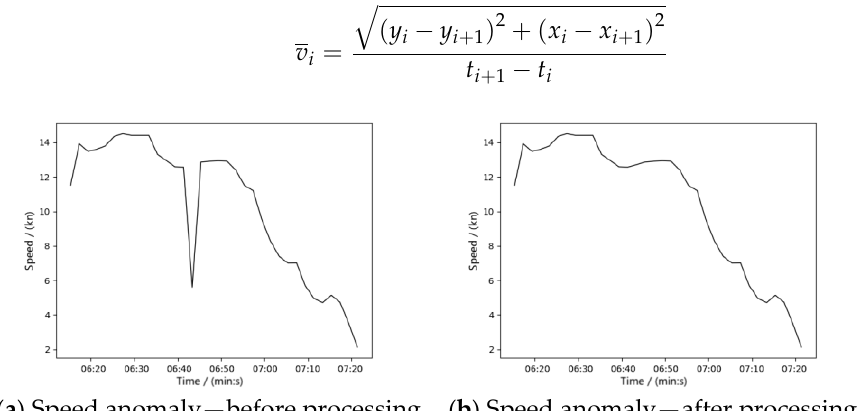
Figure 2. Trajectory point speed anomaly repair effect.